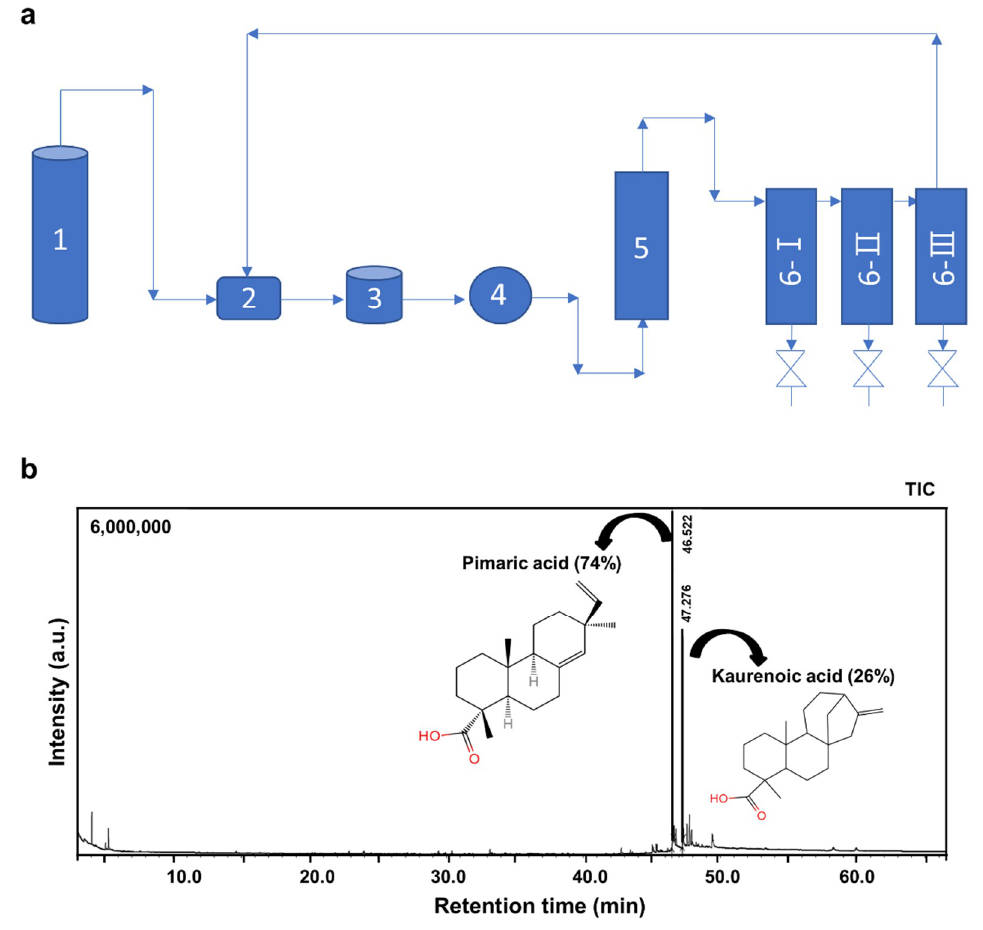
Figure 1. ( a ) Schematic drawing of the supercritical CO 2 extraction device used in this study. CO 2 source (1), a condenser (2), a CO 2 storage tank (3), a CO 2 pump (4), an extractor (5), and three separators (6). ( b ) Identification of the main compounds of AJNR extracted using the supercritical CO 2 method.